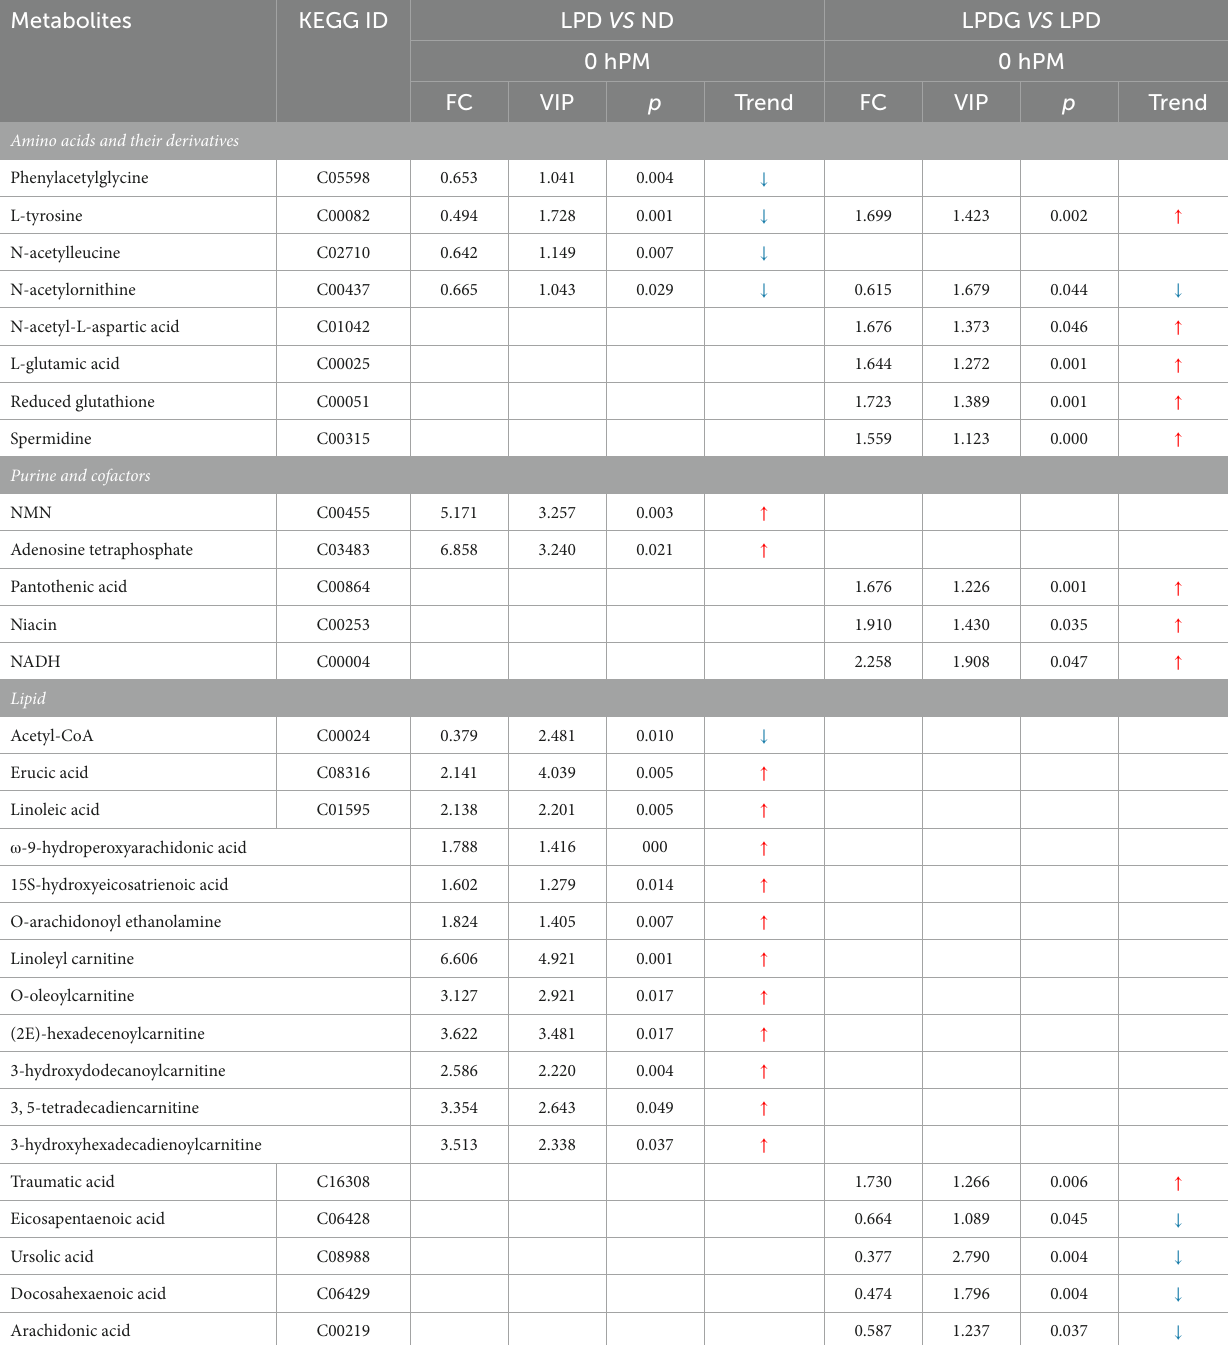
TABLE 3 Significantly altered metabolites in LT muscle (collected at 0 h PM) from pigs fed a low protein diet in comparison to pigs fed the normal diet, and pigs fed a low protein diet supplemented with glycine in comparison to pigs fed the low protein diet.